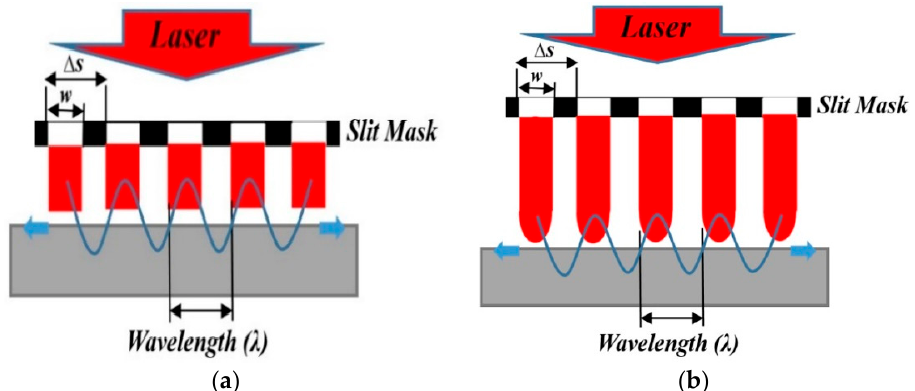
Figure 10. Schematic of the line laser sources of 1-D and Gaussian model: ( a ) One-dimensional theory; ( b ) Gaussian model.